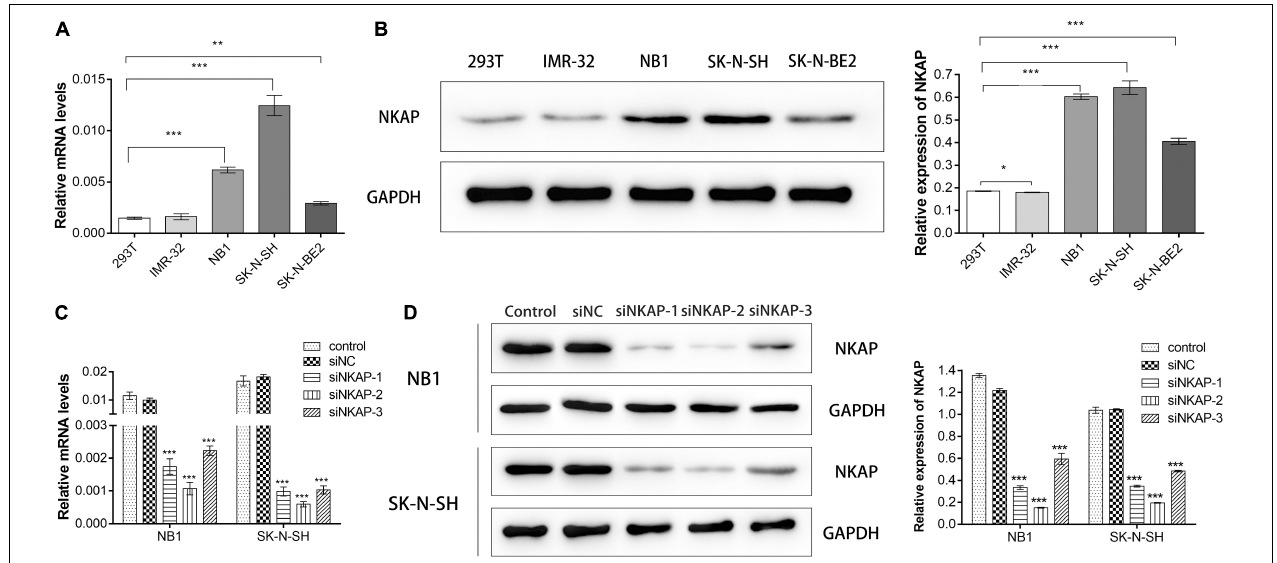
FIGURE 2 | Expression of NKAP in neuroblastoma cell lines and verify of knockdown efficiency of NKAP. NB1 and SK-N-SH cells were transfected with siNKAP-1, 2, and 3. Non-specific lentiviral vectors with non-specific were used as negative controls (siNC). (A) mRNA levels of NKAP were detected by quantitative real-time PCR. (B) Protein levels of NKAP were detected by Western blot. (C) Quantitative real-time PCR assay was performed to test knockdown efficiency of NKAP. (D) Western blot assay was performed to test knockdown efficiency of NKAP. All data were expressed as mean ± standard deviation of three independent